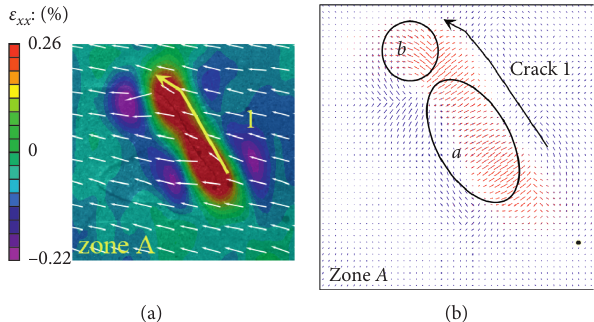
Figure 8: Cracks in mixed opening-sliding mode t � 16 h. (a) Contour map of strains ε in zone A